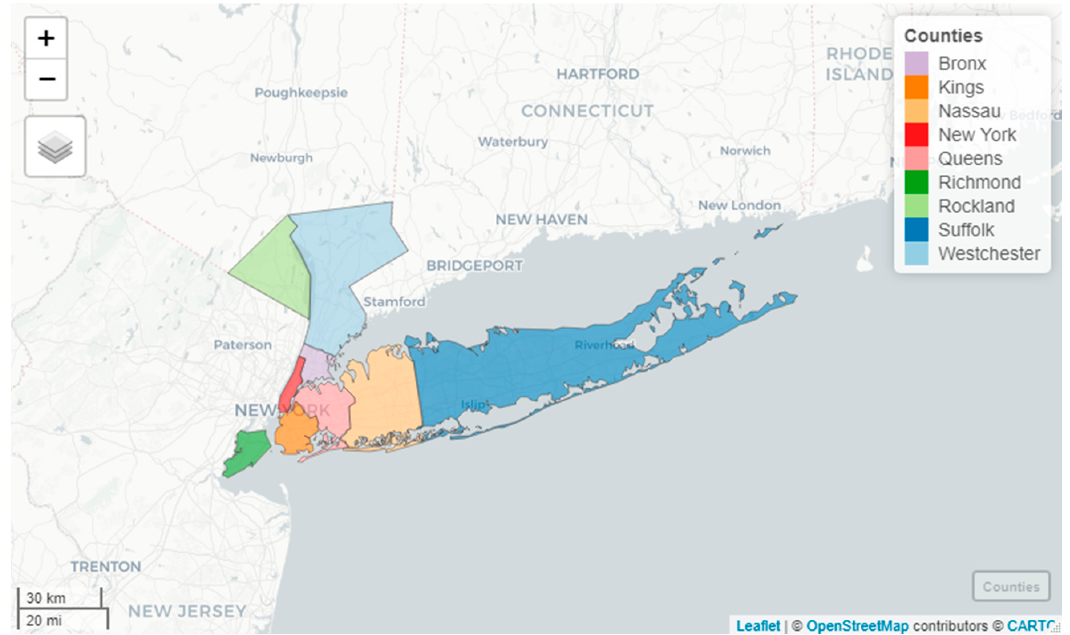
Figure 1. Study area (nine counties in the southernmost region of New York State).